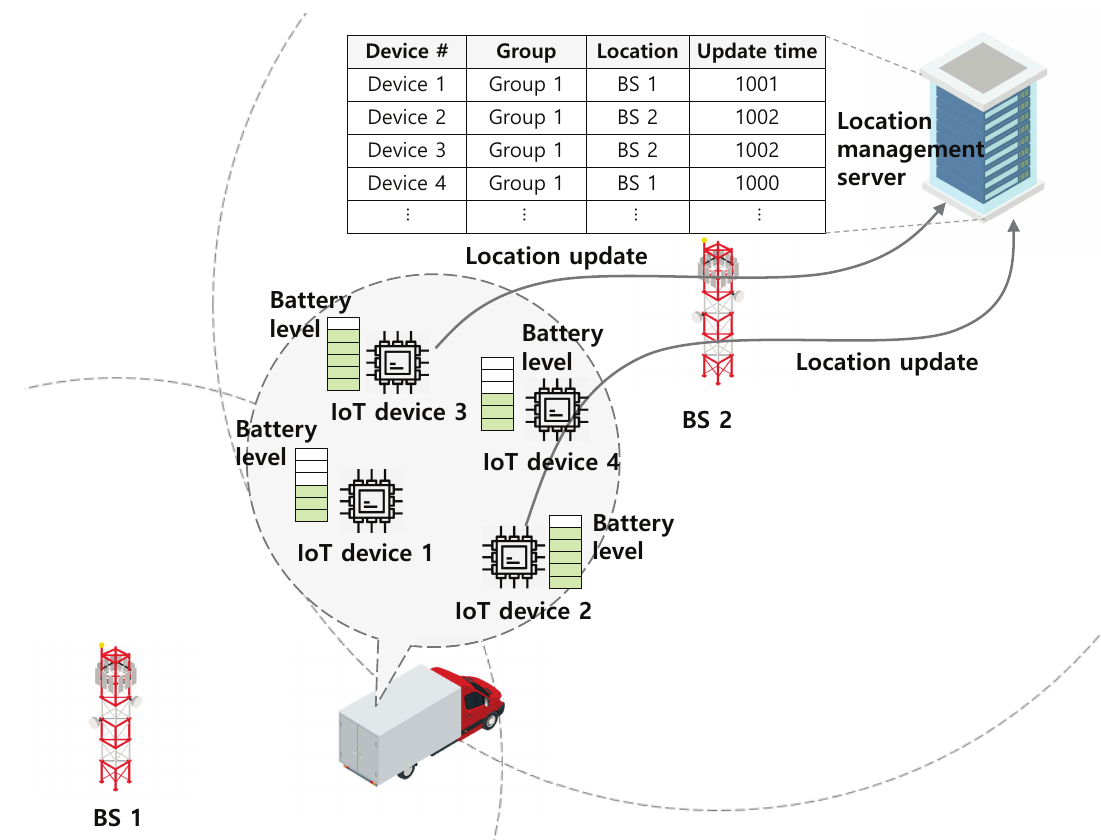
Figure 1. System model.